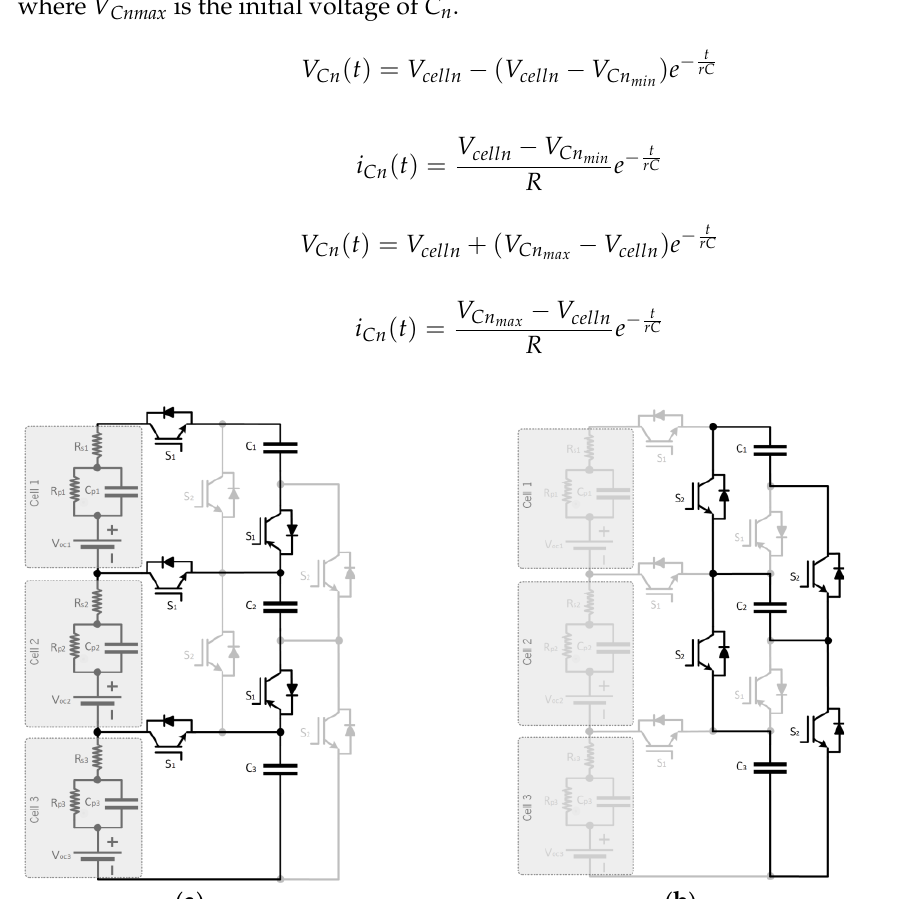
Figure 4. Operating modes of the SC converter: ( a ) first stage, T 1 ; ( b ) second stage, T 2 .